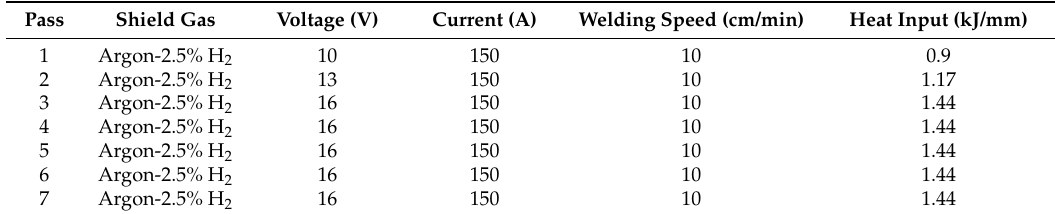
Table 3. Optimum welding conditions.